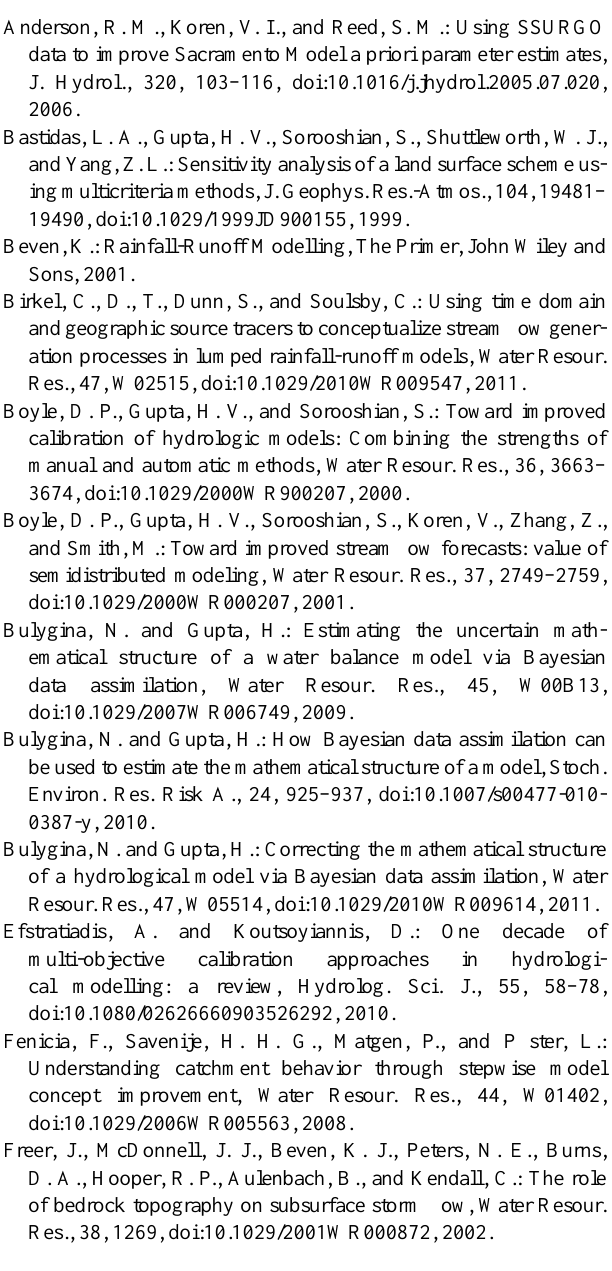
Fig. 7a, consists of samples drawn uniformly from the entire parameter space, of which less than 10 % satisfy any of the imposed constraints, and only a very few satisfy 1, 2 and 3 constraints (progressively darker shades of grey). Each pro- gressive step (see region in Fig. 7b) then consists of S = 5000 samples generated according to the strategy discussed above, in which the value of C is increased by one. Clearly, at each step, the proportion of newly generated samples satisfying larger numbers of constraints increases rapidly. Note that when C was set equal to 9 (i.e., the maximum number of design constraints), the search was continued until the pre- specified 8000 behavioral parameter sets had been found, and then terminated. At this point the fraction of number of newly generated samples (behavioral parameter sets) that sat- isfy all of the constraints has reached approximately 40 % (region in Fig.